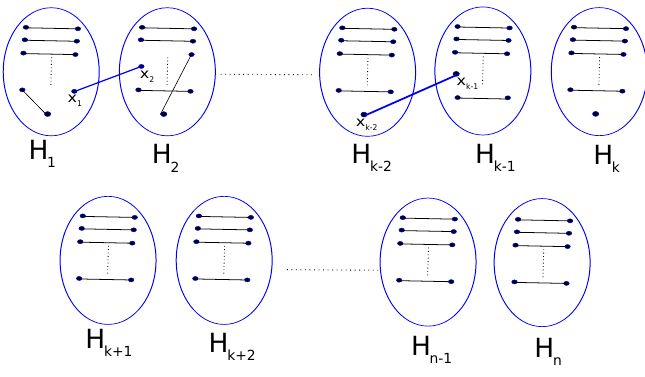
| ≤ 2 n − 7 for i ∈ { 1 , . . . , n i